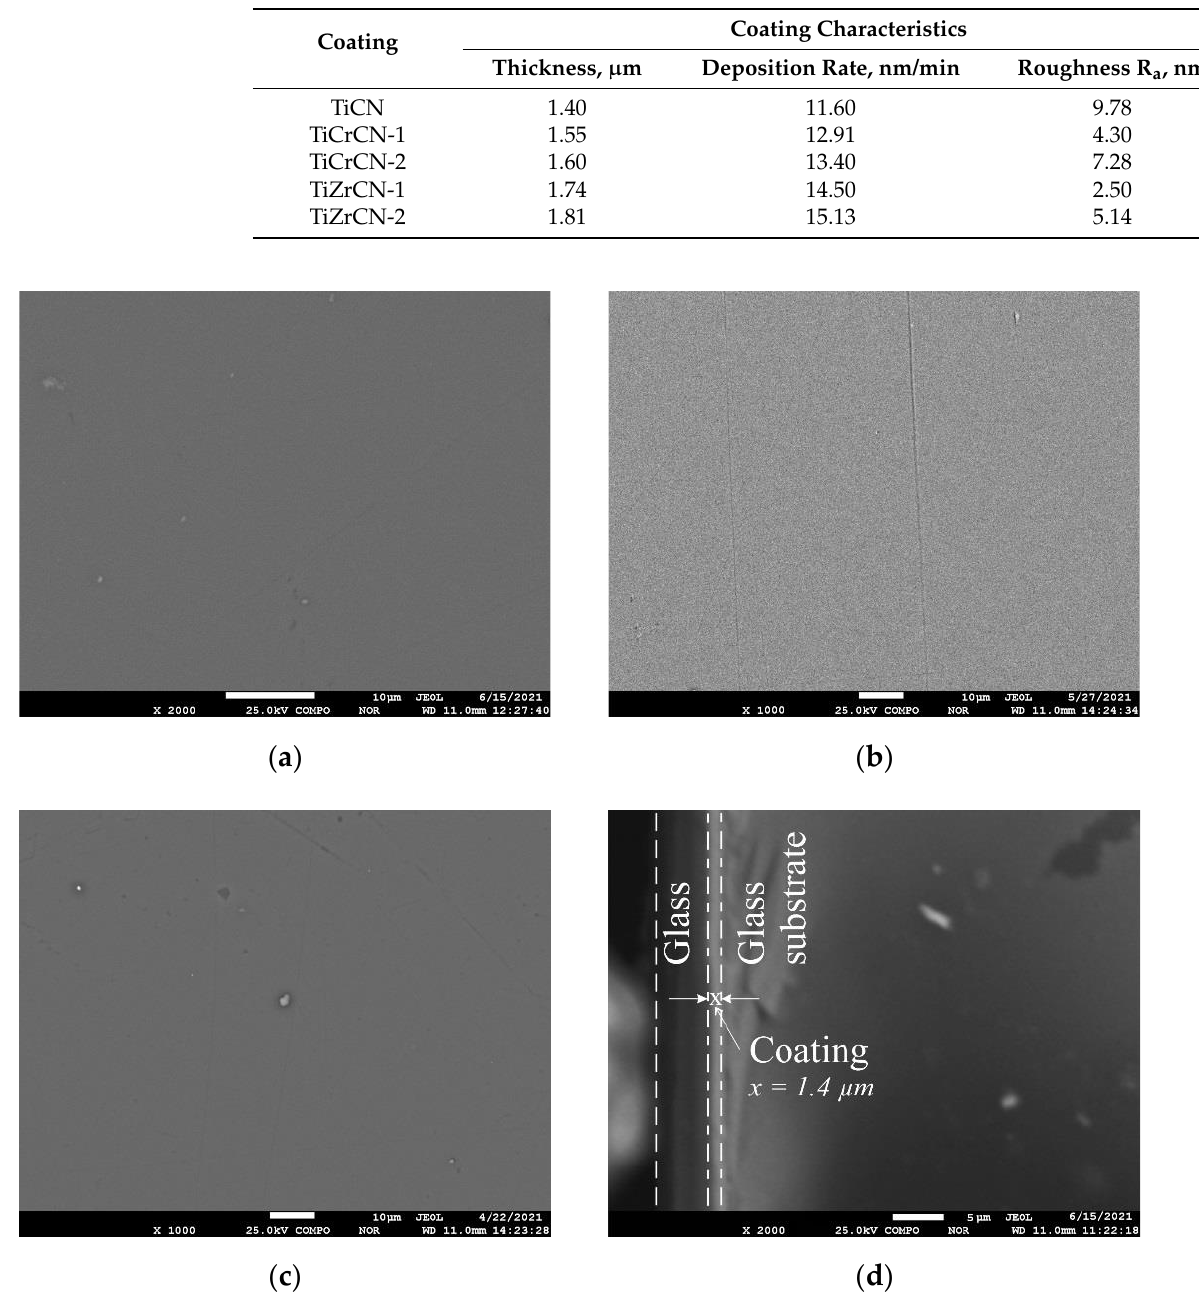
Figure 3. SEM images of the morphology of deposited coatings on titanium VT1 – 0 and the coating thickness on a glass substrate: ( a ) TiCN, ( b ) TiCrCN-1, ( c ) TiZrCN-1, and ( d ) thickness of TiCN coating.